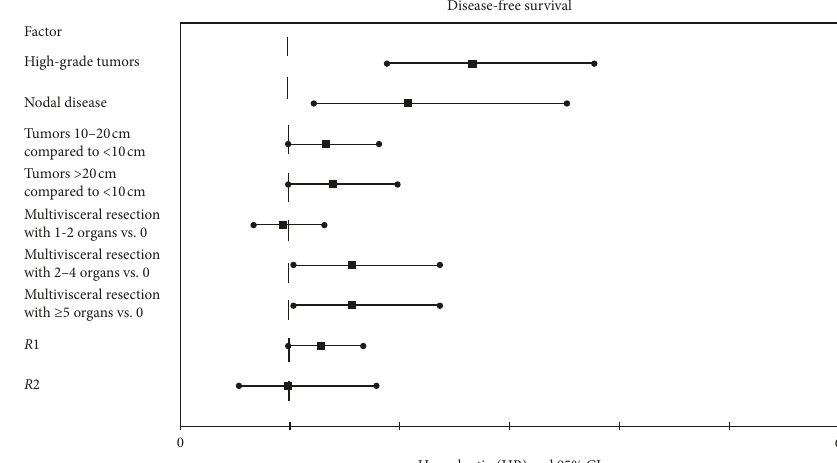
Figure 3: Forest plot demonstrating the hazard ratios and associated 95% confidence intervals for each factor included in the multivariate Cox proportional hazards model for disease-free survival.